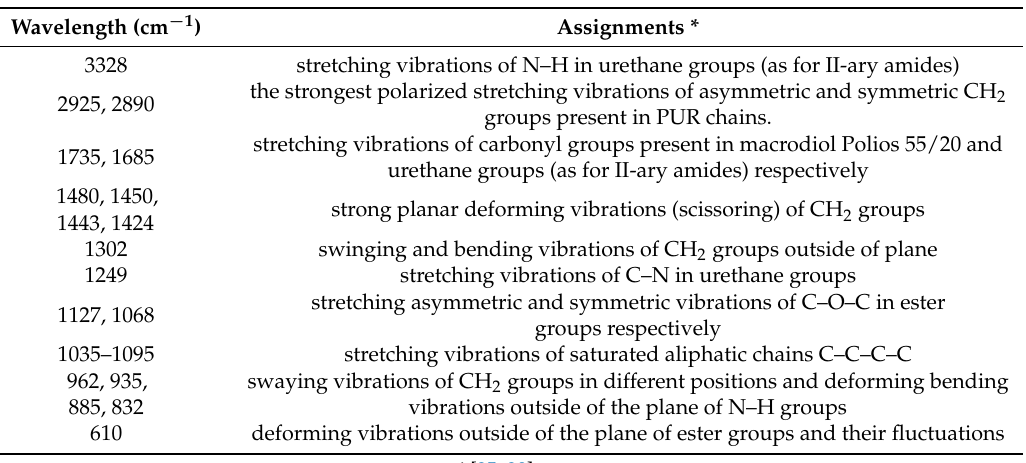
Table 3. Raman spectra band assignments for obtained PURs.